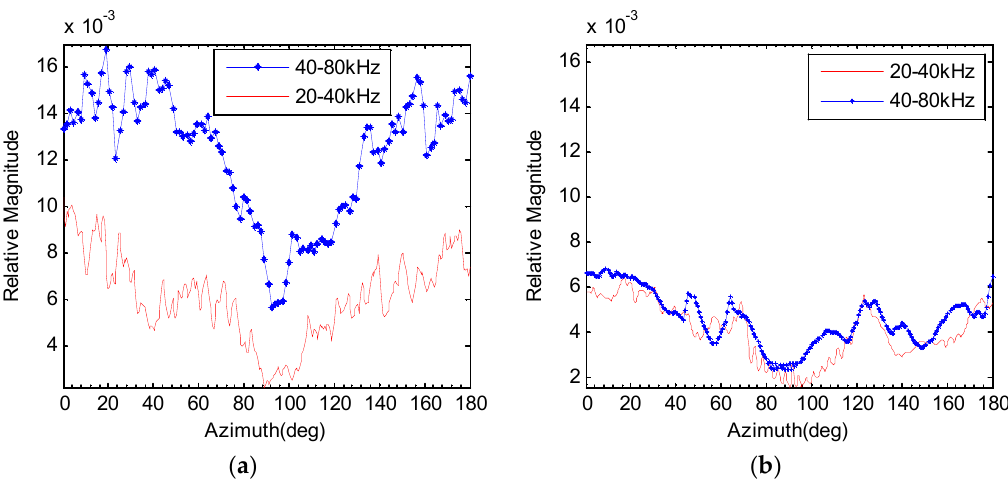
Figure 18. ( a ) Fluctuation intensity comparison of the real target wideband echo envelope with different frequencies, the pulse length is 1 ms; ( b ) fluctuation intensity comparison of the synthetic wideband echo envelope with different frequencies, the pulse length is 1 ms.